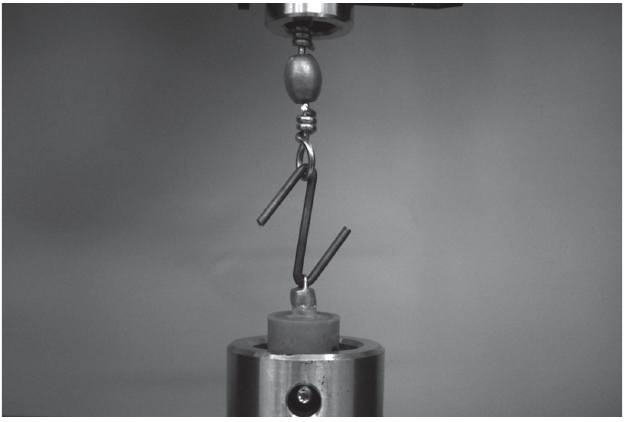
Fig. 5 – Specimen positioned in the testing machine.